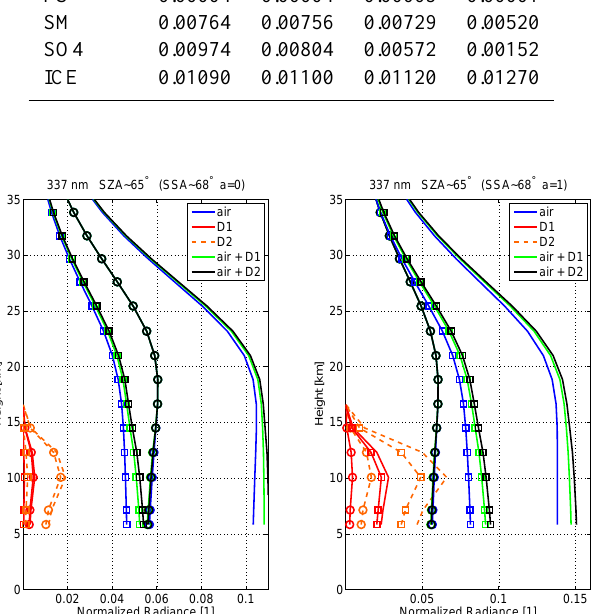
Fig. 1. Simulated limb radiance [normalized to a solar input of 1] versus height at 337nm for a surface albedo of 0 (left panel) and 1 (right panel). Color distinguishes combinations of air between 0–100km, an absorbing dust (D1) between 10–15km, and a non- absorbing dust (D2) also between 10–15km. Solid and dotted lines without markers indicate total radiance while lines with circle and square markers indicate single and multiple-scattered radiance, re- spectively, including absorption for D1. SZA indicates solar zenith angle. SAA indicates solar azimuth angle.